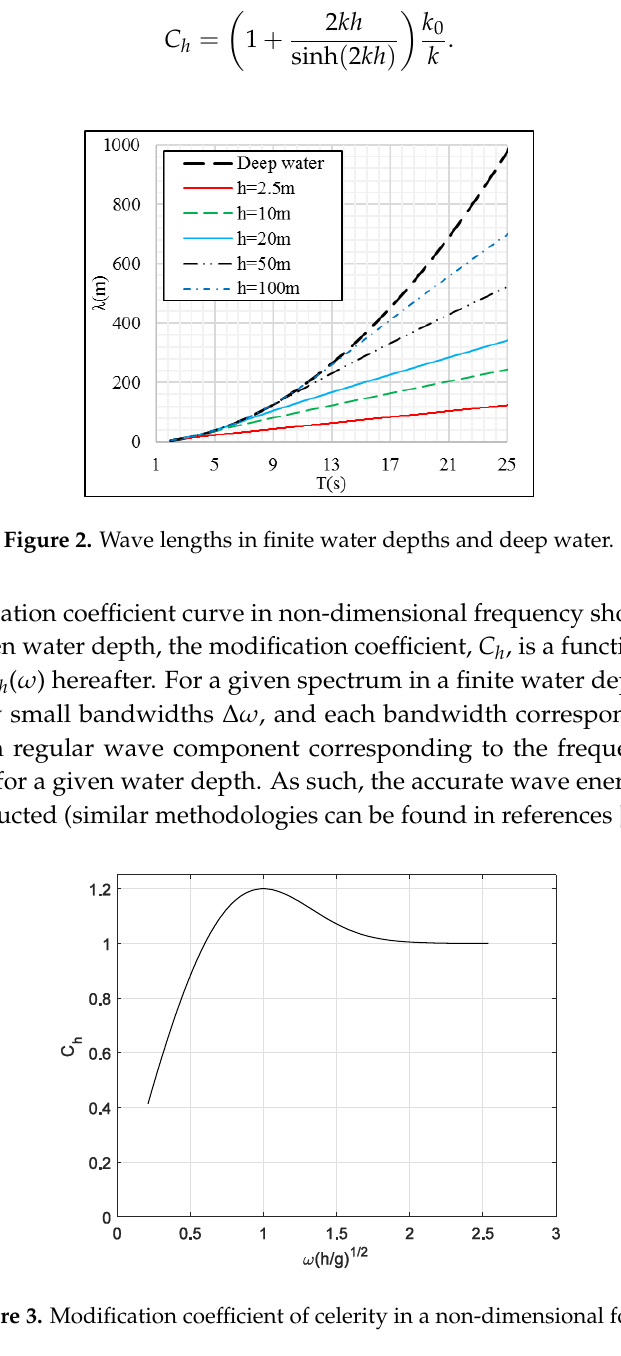
Figure 3. Modification coefficient of celerity in a non-dimensional form.